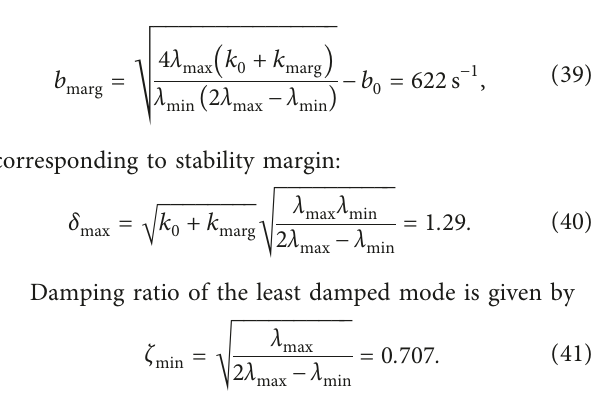
The corresponding position of dominant open- and closed-loop eigenvalues is depicted in Figure 6.